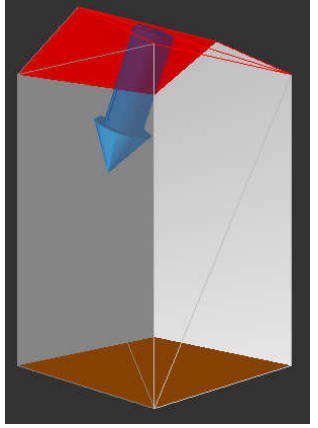
Figure 21: Orientation error of a roof polygon